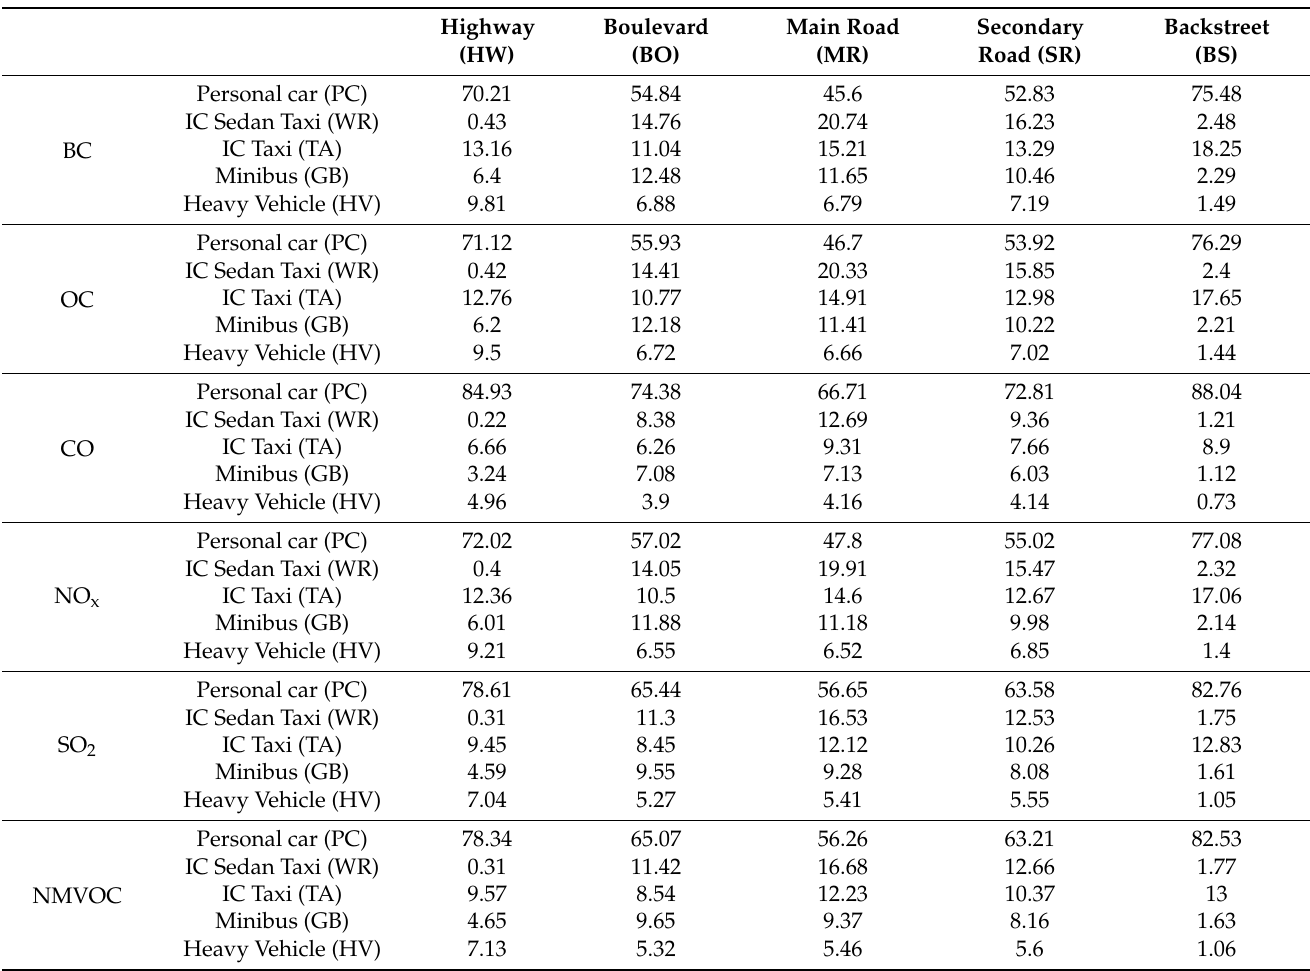
Table 3. Contribution of vehicle types to the emissions (in %) of the different pollutants (BC, OC, CO, NO x , SO 2 and NMVOC) for each road